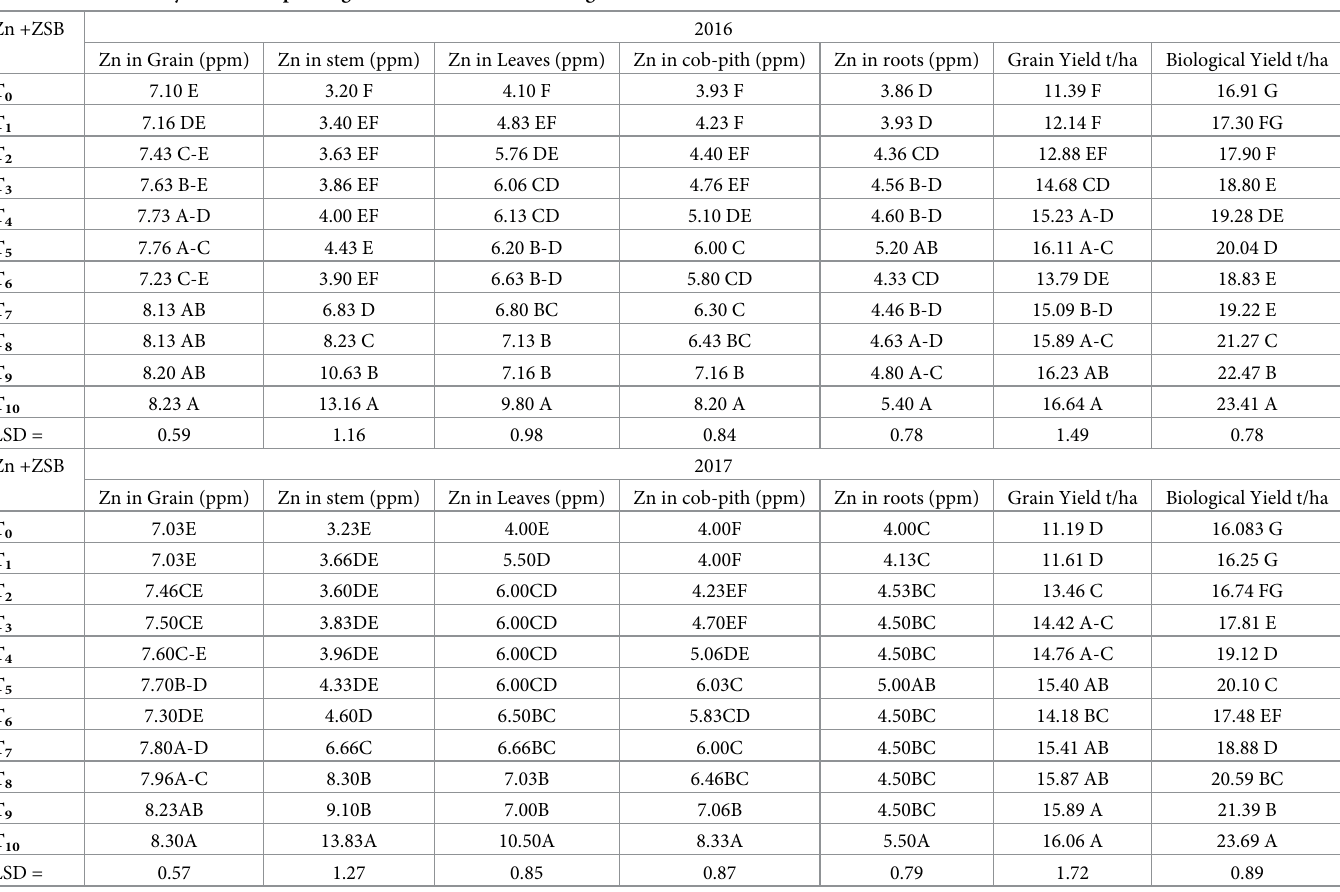
Table 3. Effect of Zn lysine chelate priming and inoculation of ZSB on agronomic traits of